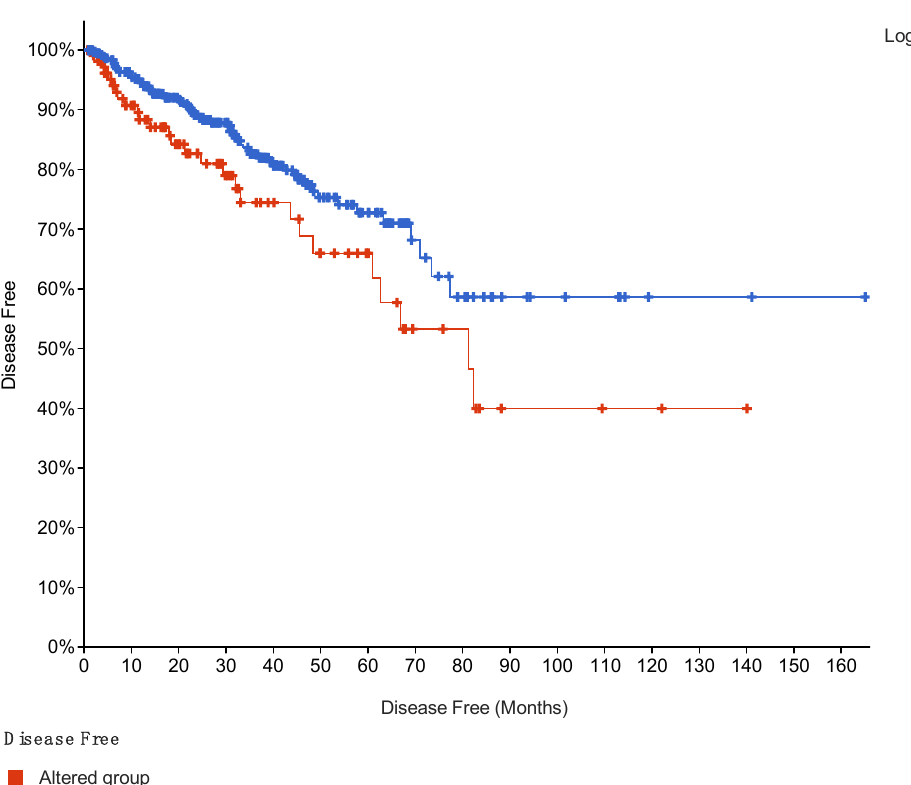
Figure 2. PFS survival was analyzed using Kaplan–Meier curve analysis and compared to patient population harboring alterations in the connective tissue genes (red) vs. the population without any genetic alterations in the connective tissue genes (blue).